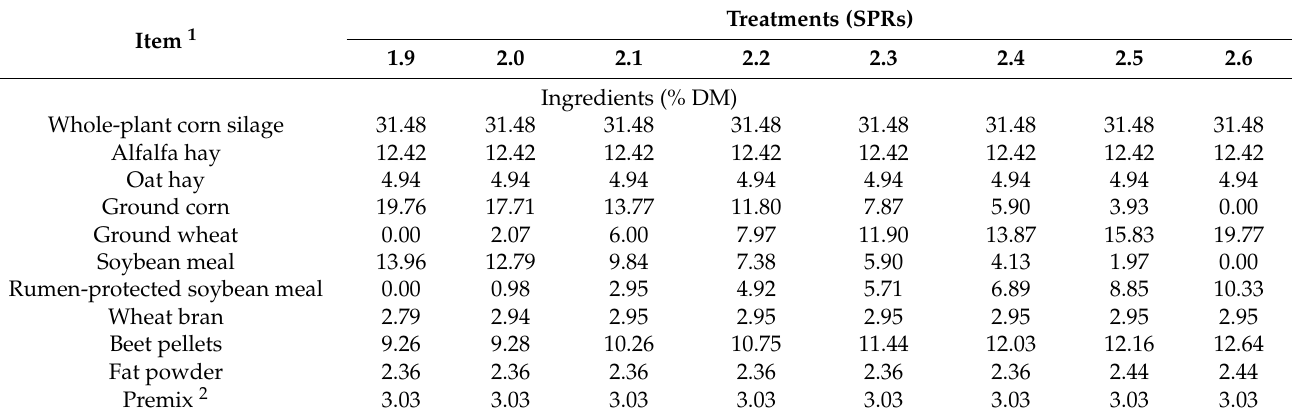
Table 1. Ingredients and chemical compositions of diets with different rumen-degradable starch to rumen-degradable protein ratio